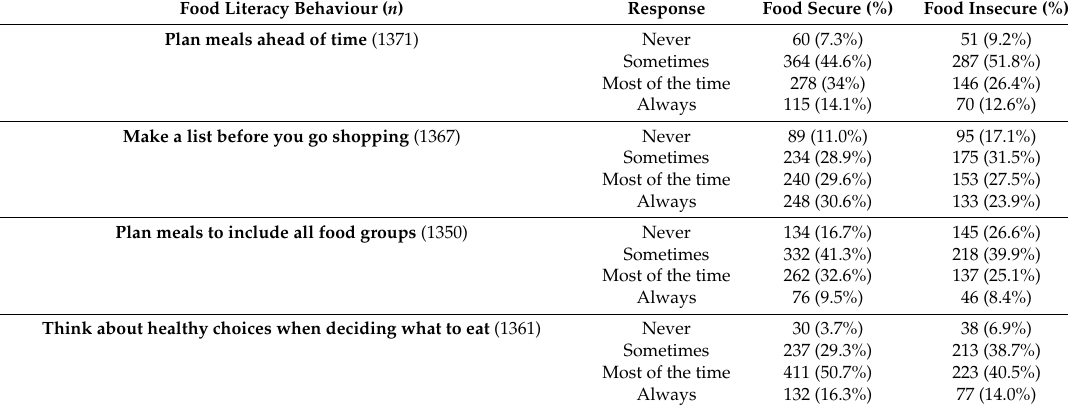
Table 3. Food literacy behaviours of participants attending the Food Sensations ® for Adults programs between May 2016 and April